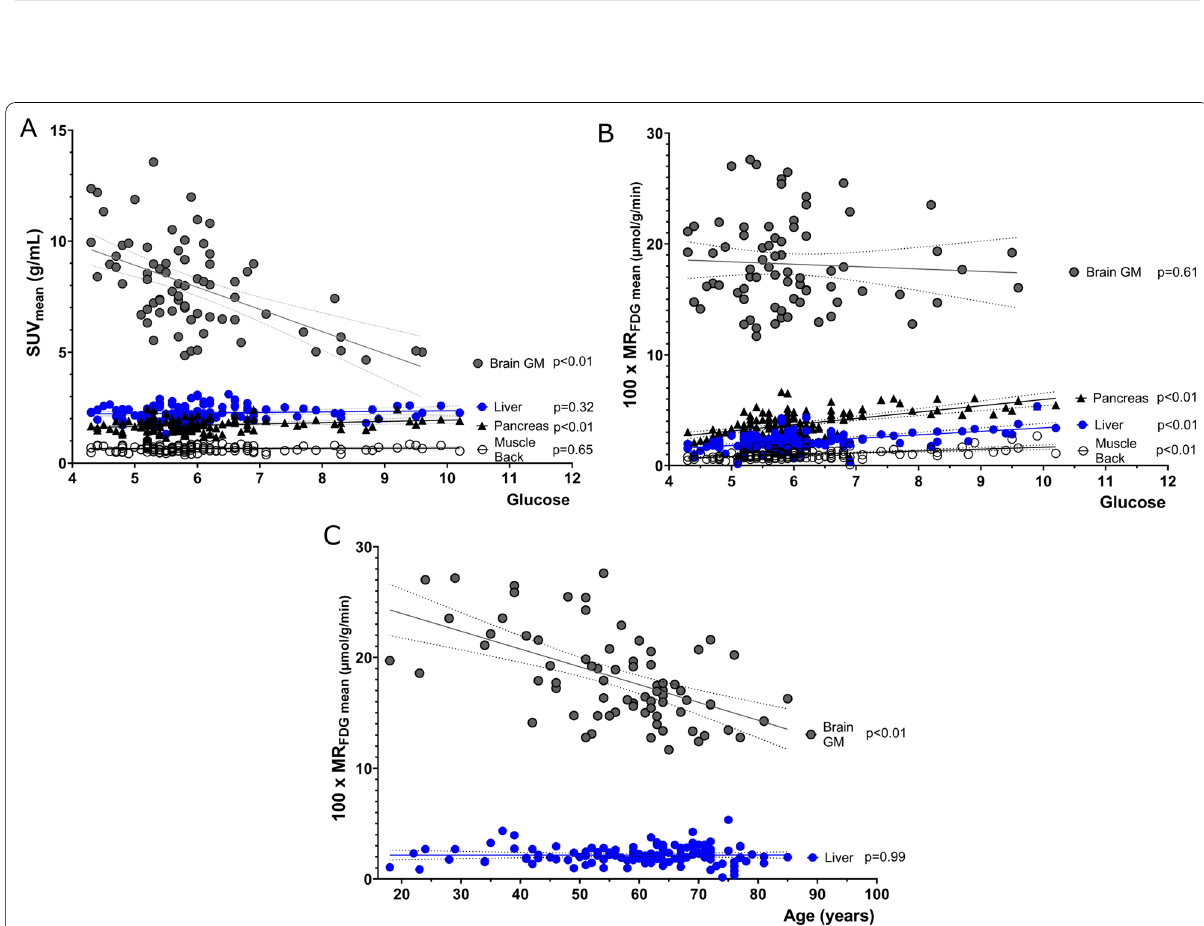
Fig. 5 A Correlation between multiparametric MR FDG values and manual TAC-based MR FDG estimates using PMOD’s PKIN module. N corresponding to 110 correlation points. B Bland–Altman analysis of %Difference (100*(Multiparametric MR FDG